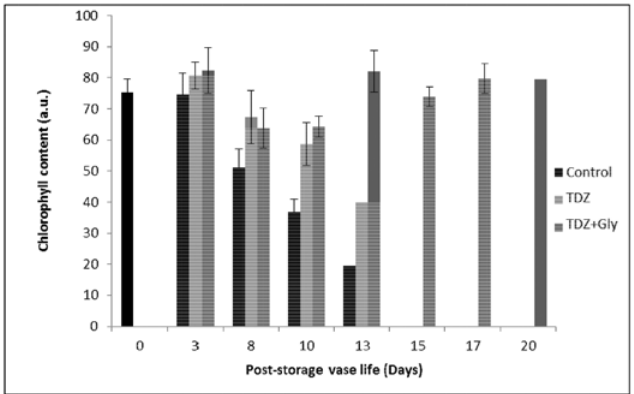
Fig. 2 - Chlorophyll content during vase life of cut Danae branches stored for 60 days. Chlorophyll was measured using a chloro- phyll meter and expressed as relative units. Values are means with standard errors ( n=8